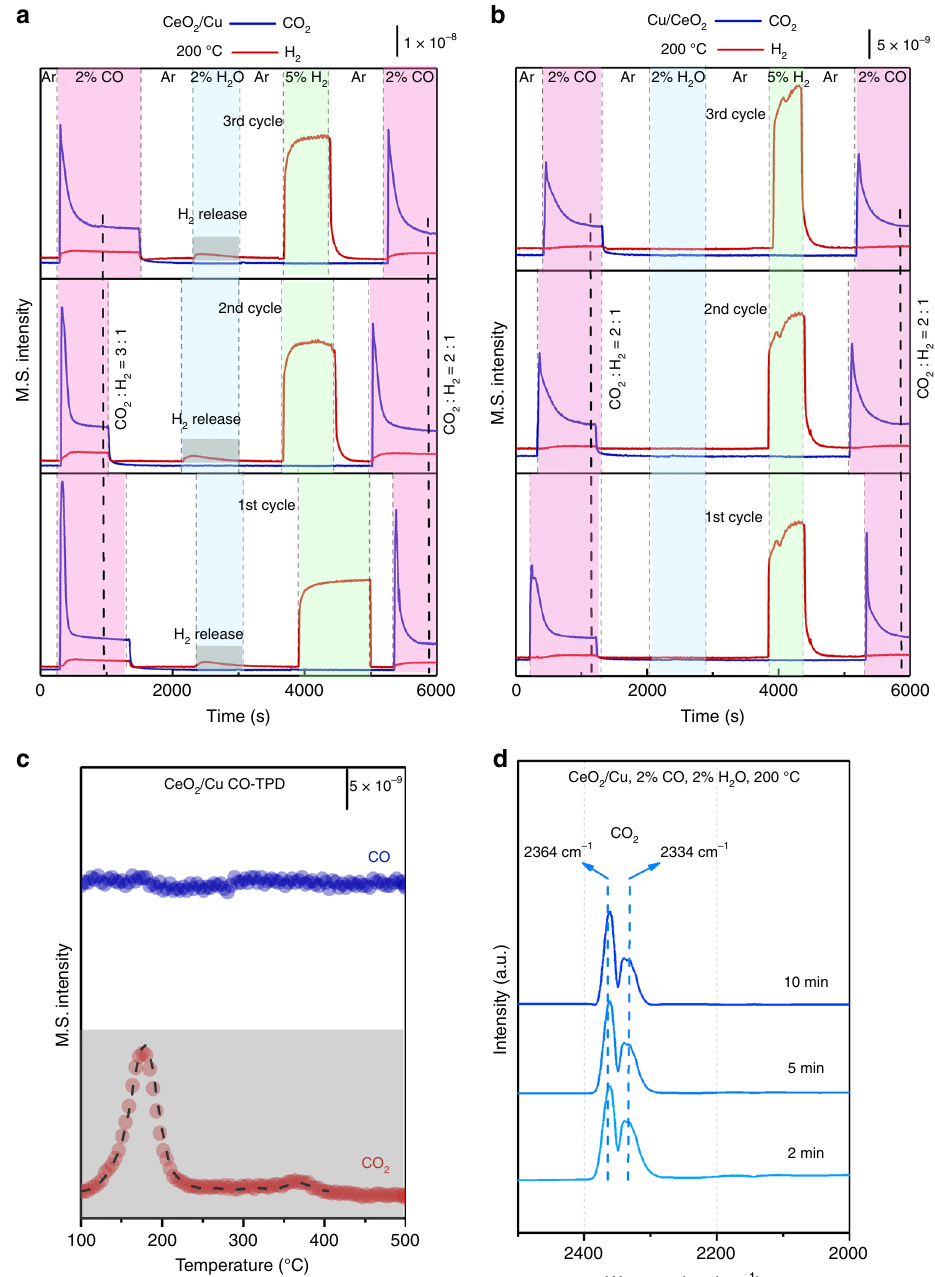
Fig. 4 WGS mechanism study of the inverse CeO 2 /Cu catalyst. a Temperature-programmed surface reaction (TPSR) on the inverse CeO 2 /Cu with consecutive switch of CO, H 2 O, and H 2 at 200 °C. b TPSR on normal Cu/CeO 2 with consecutive switch of CO, H 2 O, and H 2 at 200 °C. c Temperature- programmed desorption of CO (CO-TPD) and d in situ diffused re fl ectance infrared Fourier transform spectroscopy (DRIFTS) results of the inverse CeO 2 / Cu under the WGS conditions (2%CO/2%H 2 O/Ar, at 200